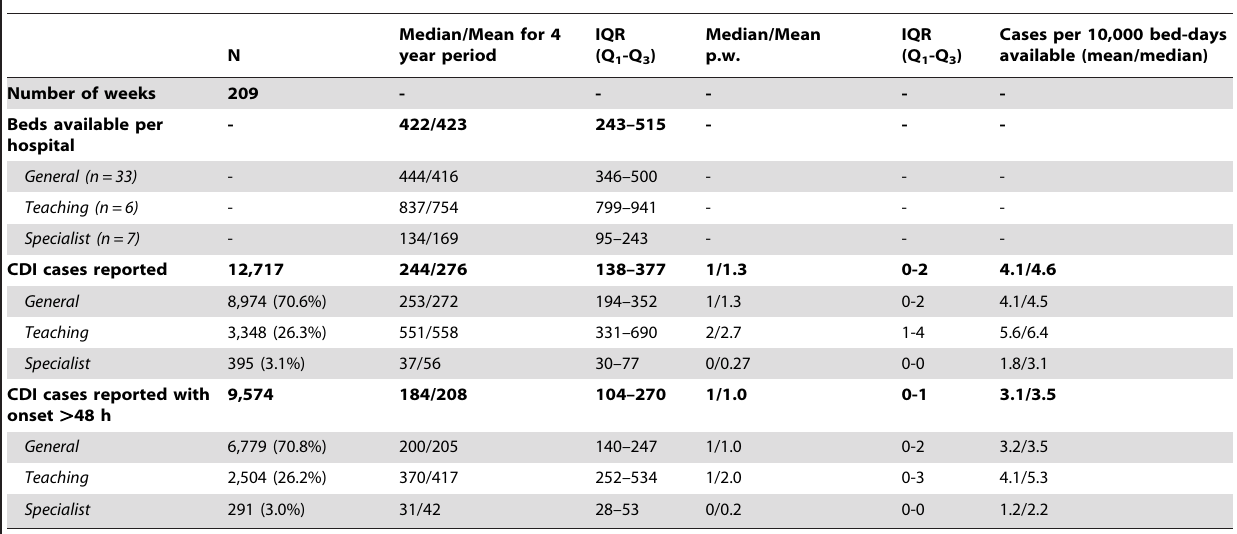
Table 1. Description of CDI data from 46 selected